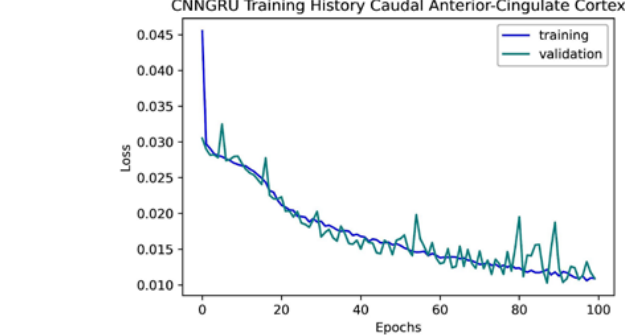
Figure 7. Training and validating the history of the models. Left : LSTM. Right : CNNGRU.